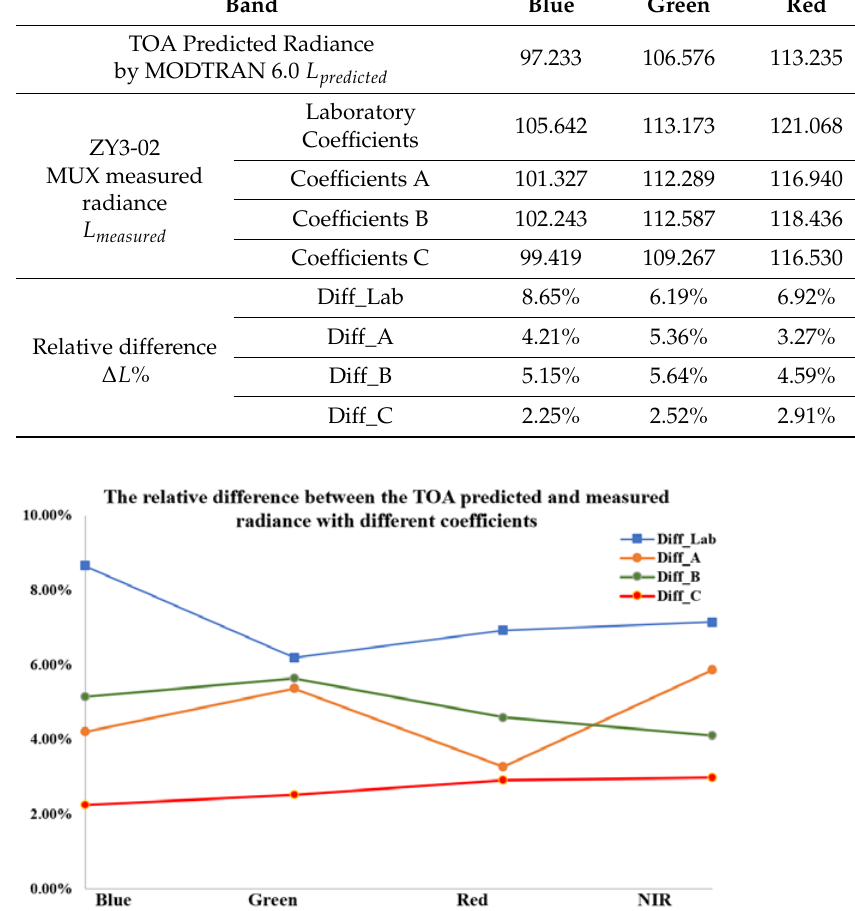
Figure 13. The relative difference between the TOA predicted and measured radiance with different coefficients. Table 7. The relative difference between the TOA predicted and measured radiance (in units of 2